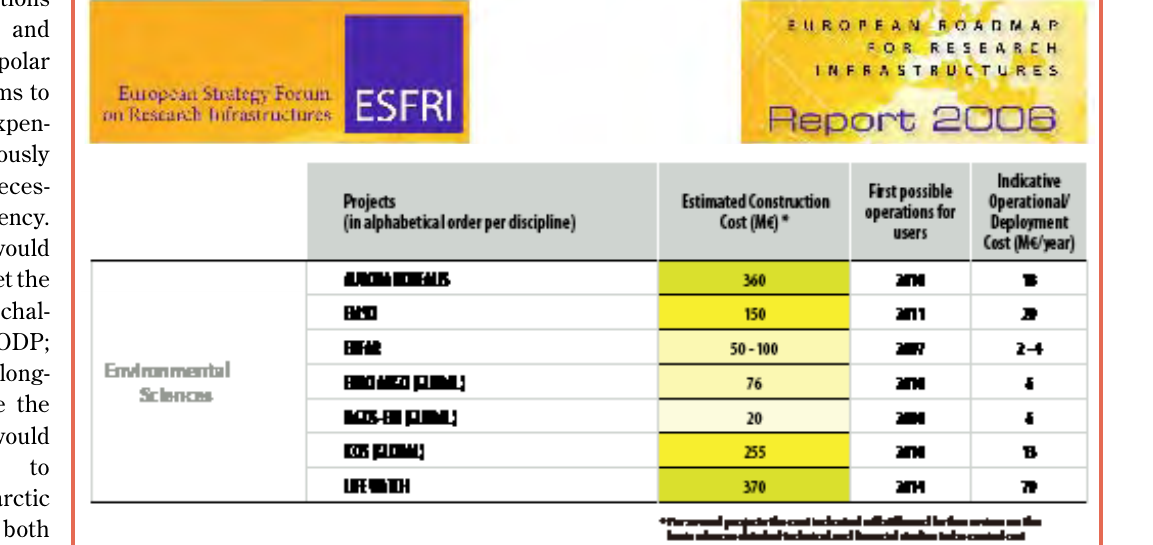
Figure 3. ESFRI Roadmap 2006 of the European Commission (http://www.eubuero.de/arbeitsbereiche/infrastruk-